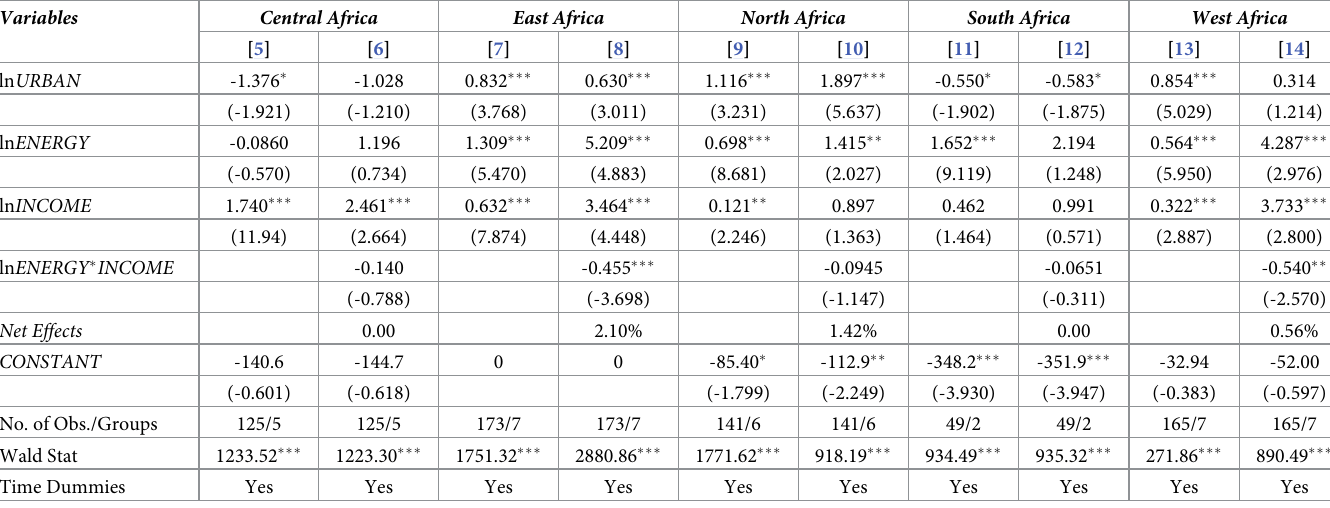
Table 4. FGLS results for the regions (Dep. Variable: